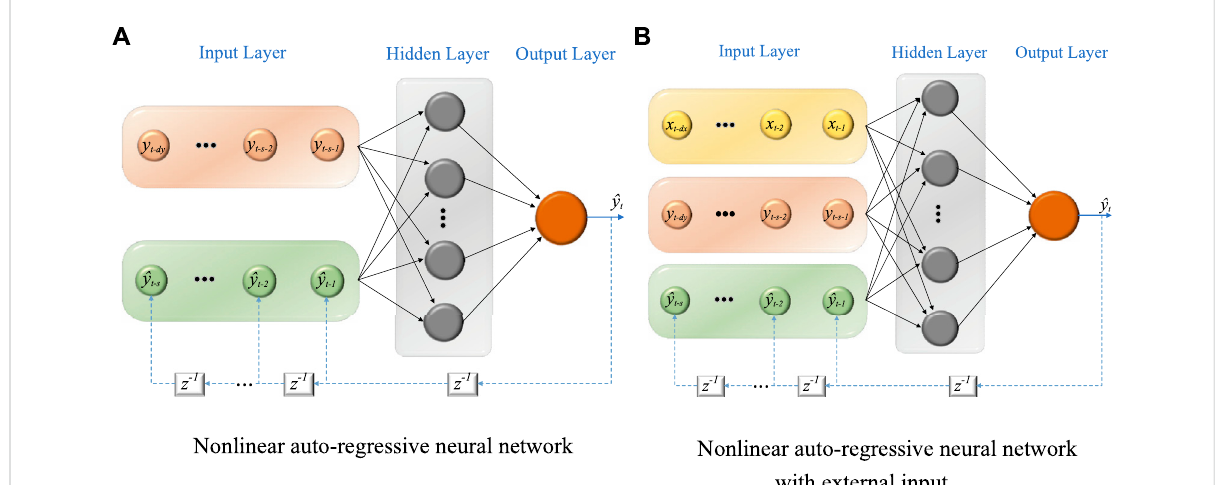
FIGURE 1 Two kinds of neural network structure, where z − 1 is the unit time delay. (A) Nonlinear auto-regressive neural network. (B) Nonlinear auto- regressive neural network with external